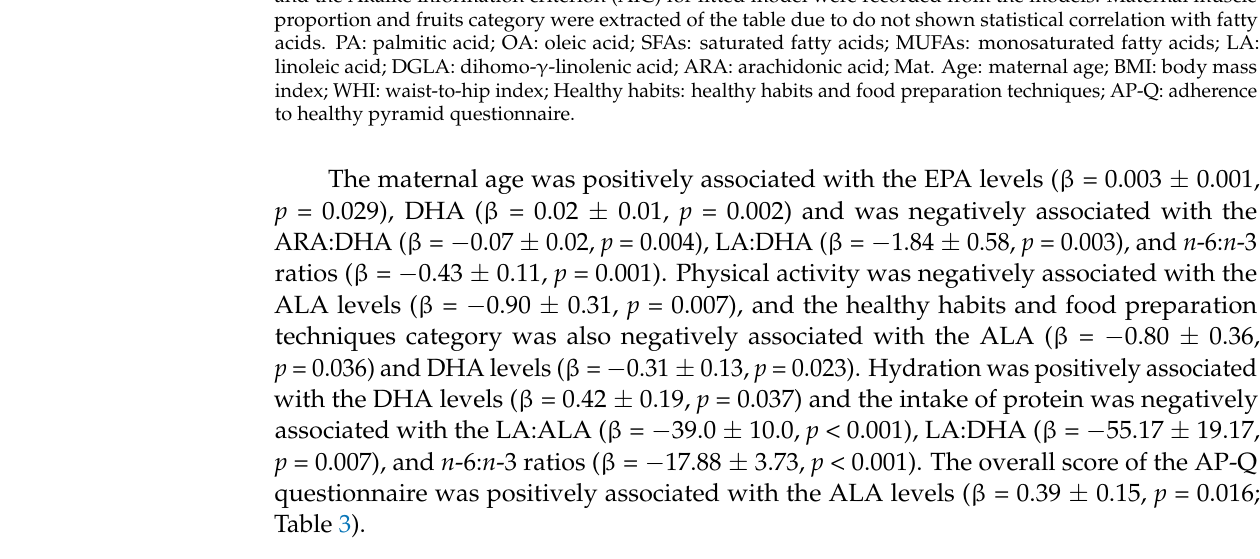
Table 3. Association between breast milk omega-3 fatty acids and ratio with maternal body composi- tion and nutritional